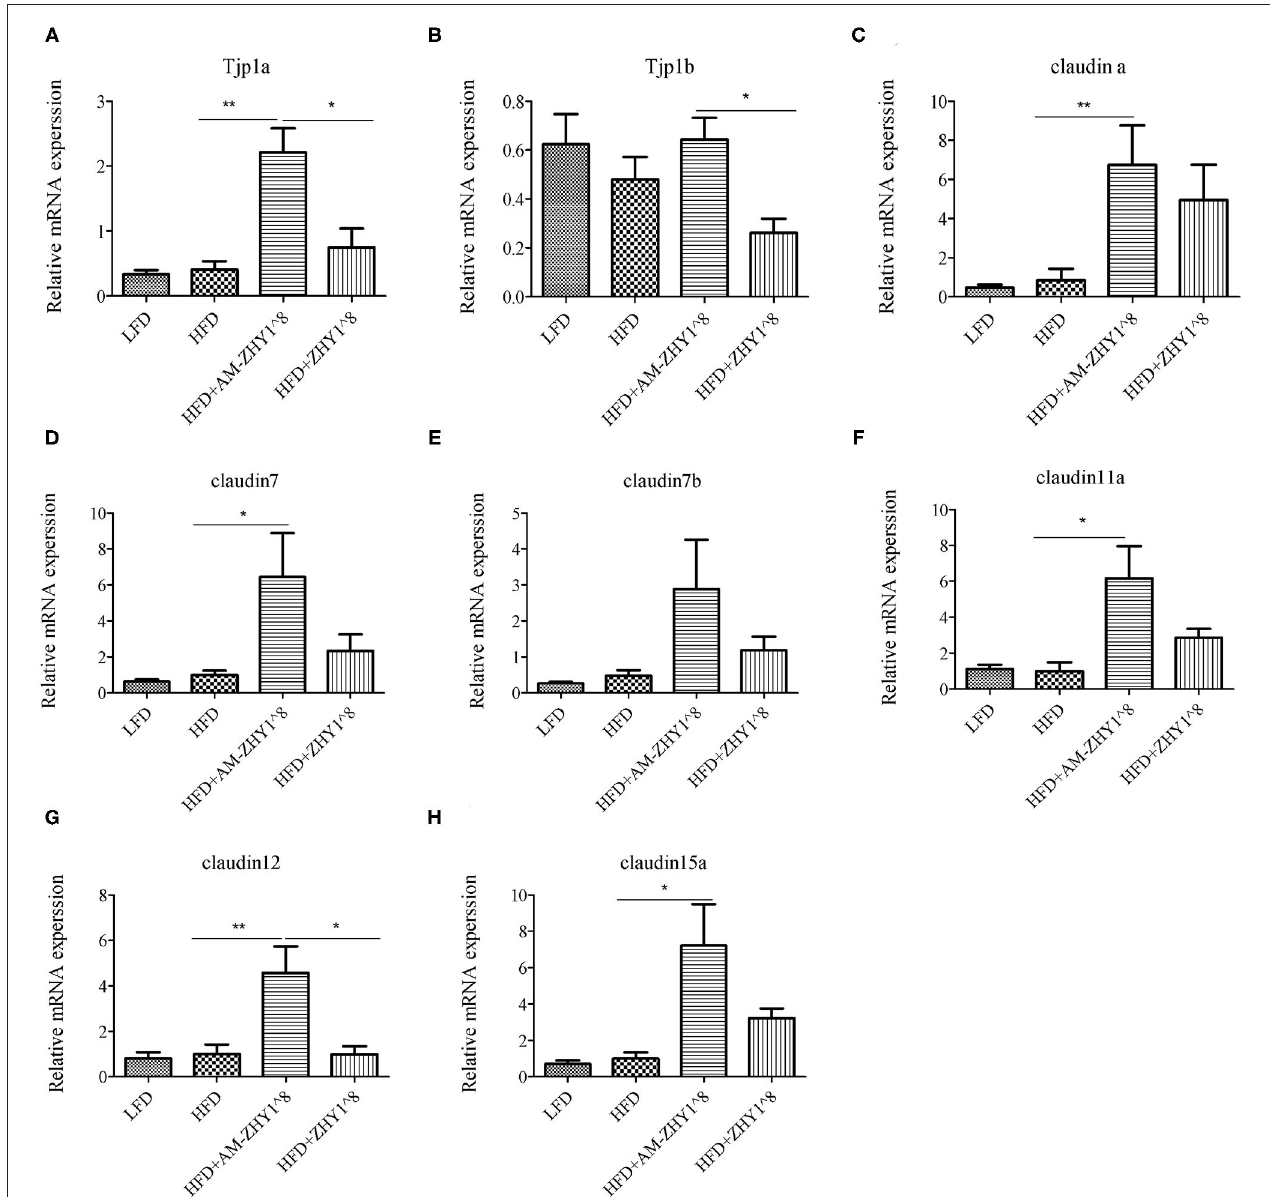
FIGURE 9 | Relative mRNA expression of the tight junction protein genes TJP1a (A) , TJP1b (B) , Claudina (C) , Claudin7 (D) , Claudin7b (E) , Claudin11a (F) , Claudin12 (G) , Claudin15a (H) of the intestines of zebrafish in different groups. Data are presented as mean ± SEM ( n = 6). The asterisks on the horizontal line represent significant differences between the two groups. (* p < 0.05,** p <